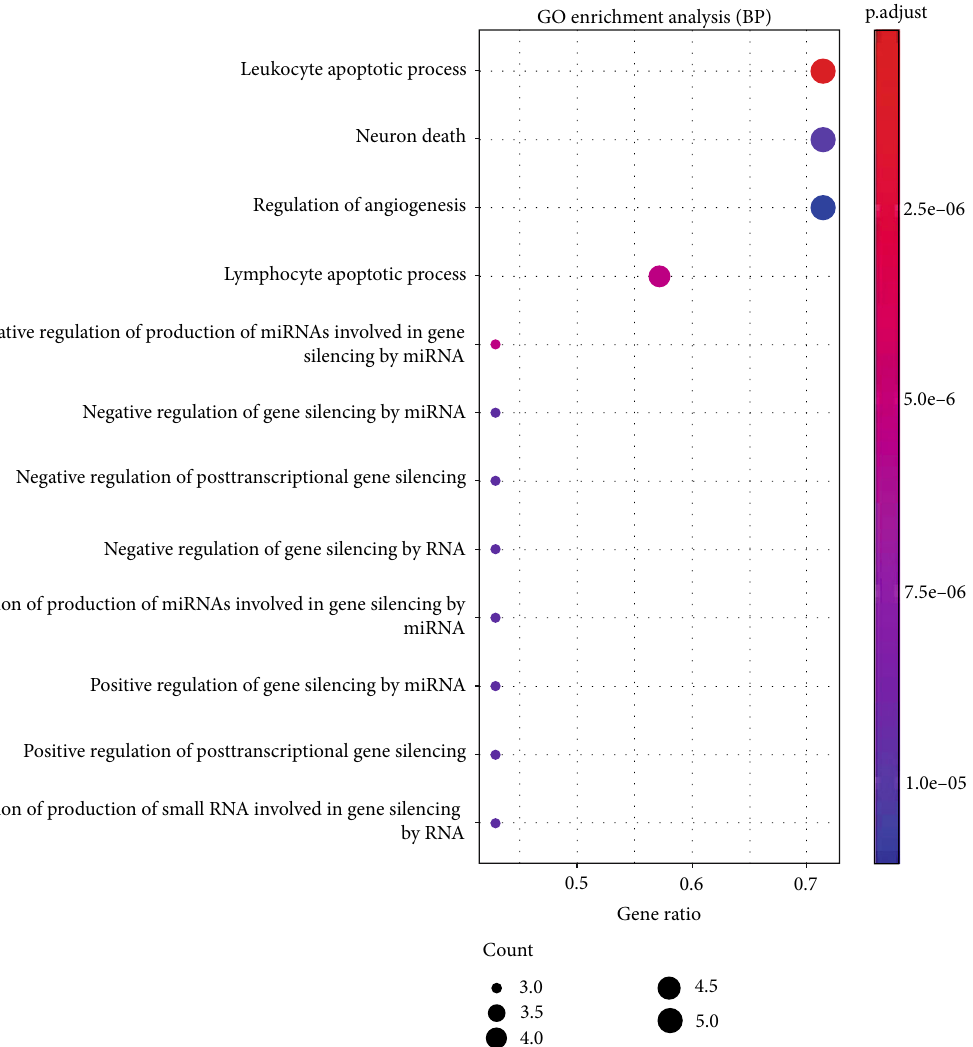
Figure 4: GO enrichment analysis of the SSd-HT hub